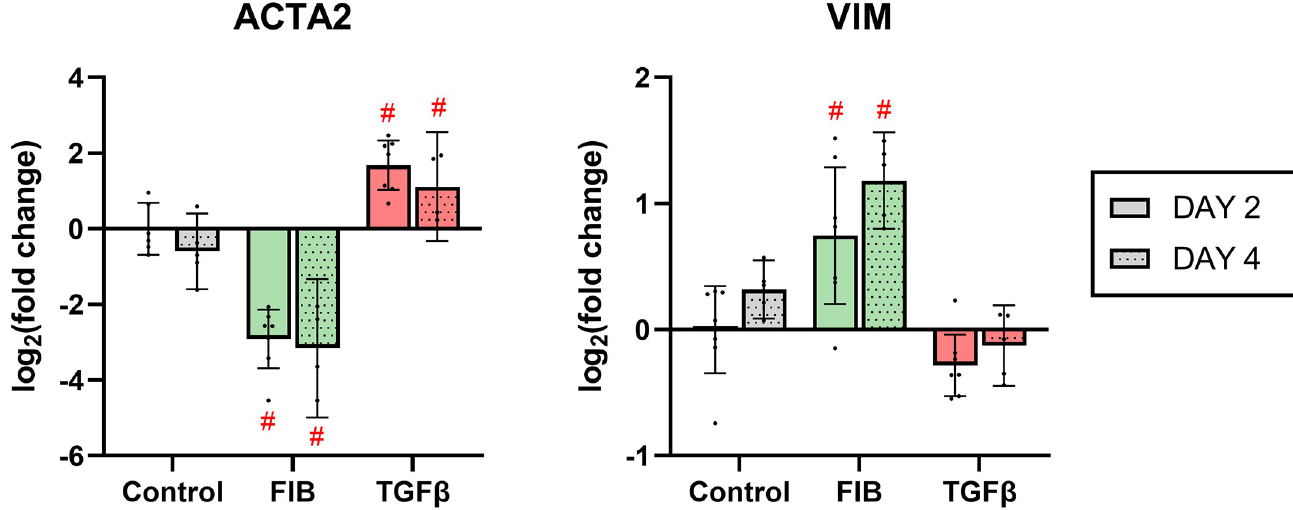
Fig 4. FGF-2 downregulates ACTA2 expression. RT-qPCR results of ACTA2 ( α -SMA) and VIM (vimentin) expression. In a mixed effects ANOVA, experimental groups were compared to control at each time point. � p < 0.05, #p < 0.01, dots represent biological replicates (n = 7 on day 2, n = 5 on day 4), error bars represent 95%